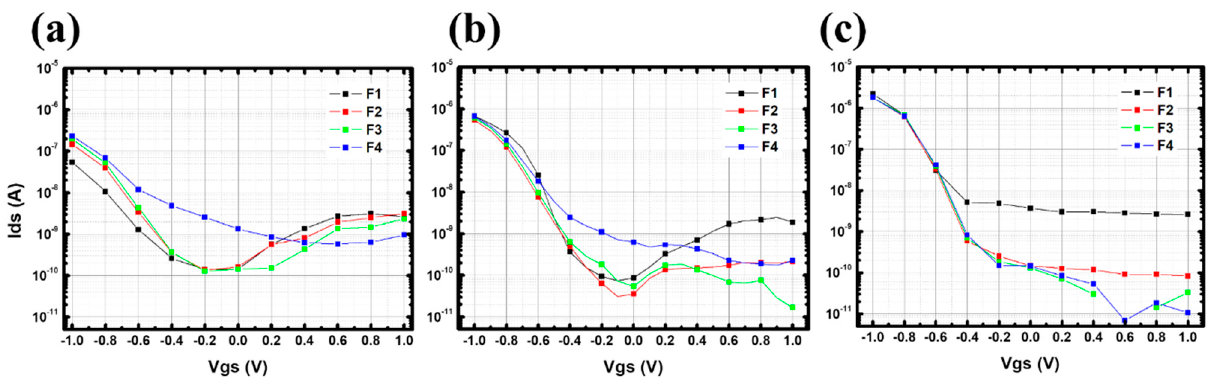
Figure A3. Logarithmic I–V transfer curve of f-CNTFETs in pH 7 phosphate buffer solution (PBS) after ( a ) 2 months ( b ) 3 months and ( c ) 9 months. All transistors were 5 µm channel devices. V ds was set to +0.8 V and V gs was swept from − 1 V to +1 V.